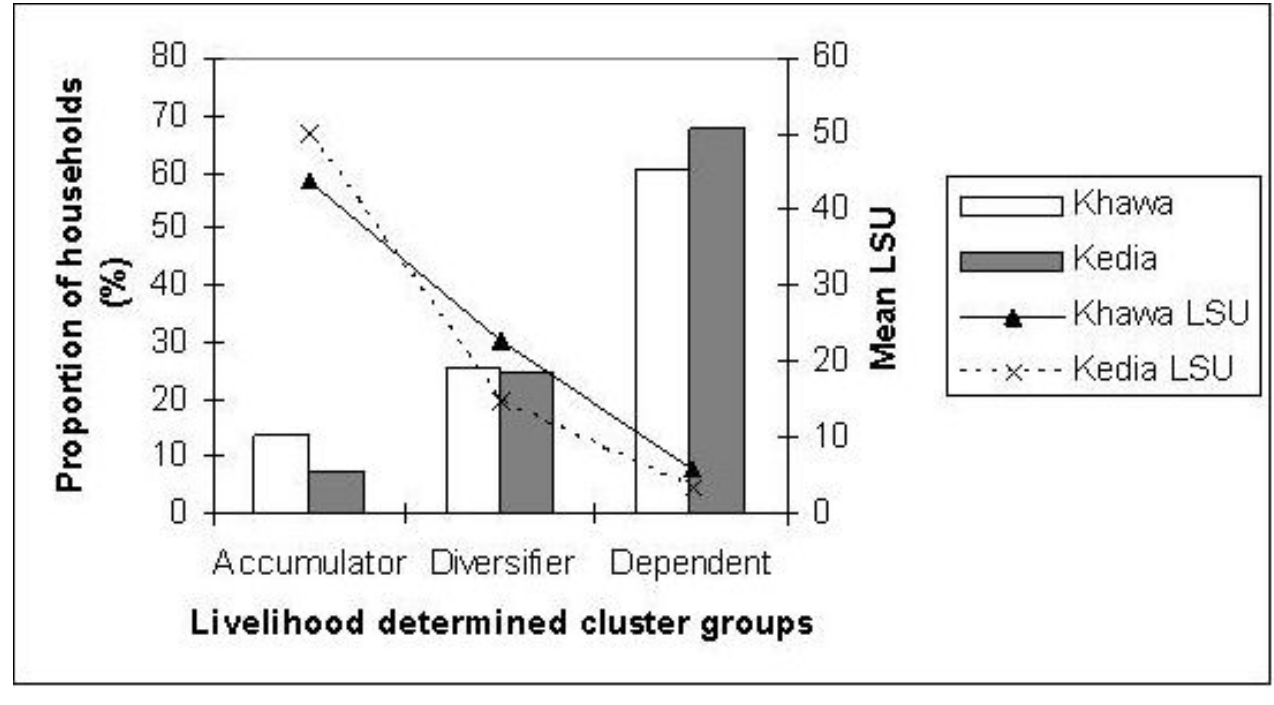
Fig. 7 . Proportion of households in livelihood-determined cluster groups (strategy groups) and respective mean livestock unit (LSU) values for each group in Khawa and Kedia in 2004 and 2005. Refer to Table 3 for full description of cluster group livelihoods. Livestock units: 1 cow = 1 LSU; 5 goats/sheep = 1 LSU (Sallu